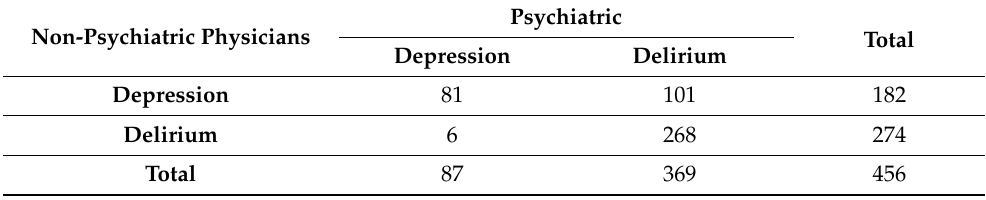
Table 5. Diagnostic accuracy between non-psychiatric physicians and CLP